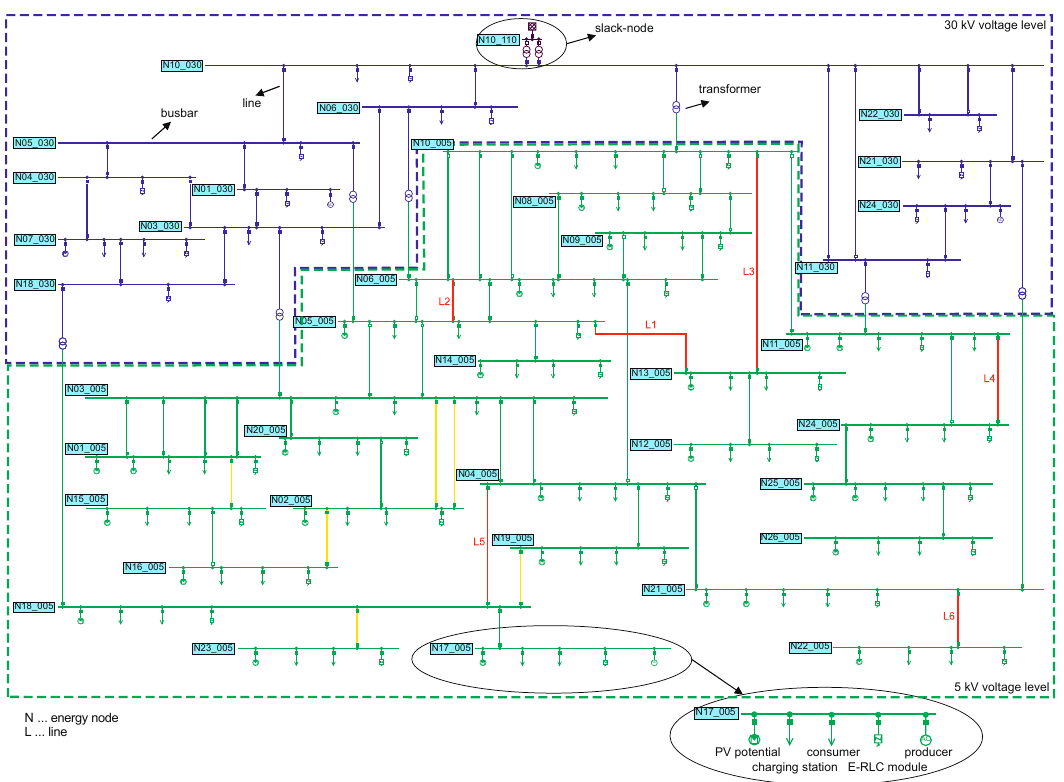
Figure 10. Simplified cell-based grid model for the city of Leoben.